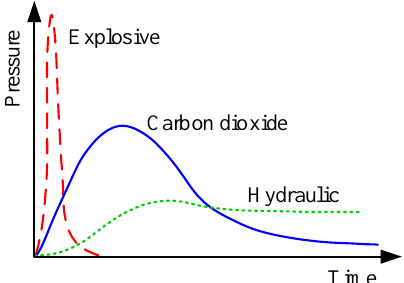
Figure 4. Pressure curve diagram of explosive blasting, liquid carbon dioxide blasting, and hydraulic.